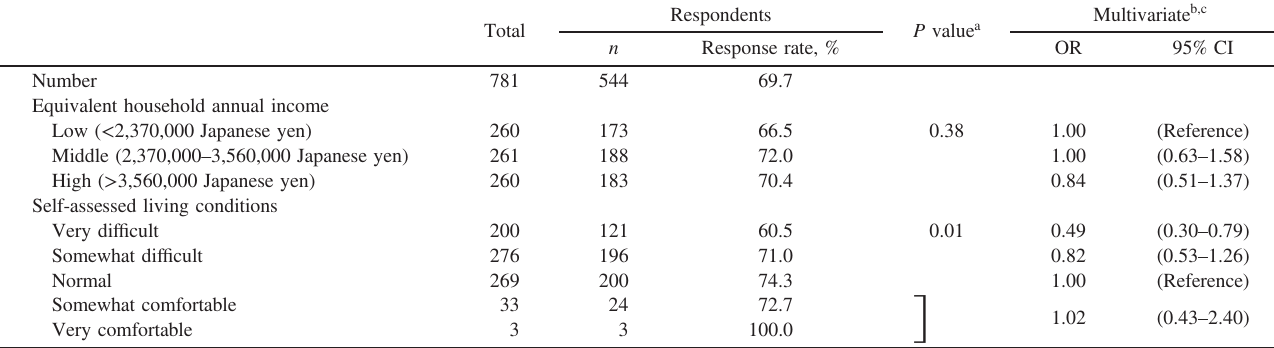
Table 2. Response rates and odds ratios for response to the 2015 National Nutrition Survey on Preschool Children, Japan, according to economic characteristics among children aged < 6 years and their households who answered an income